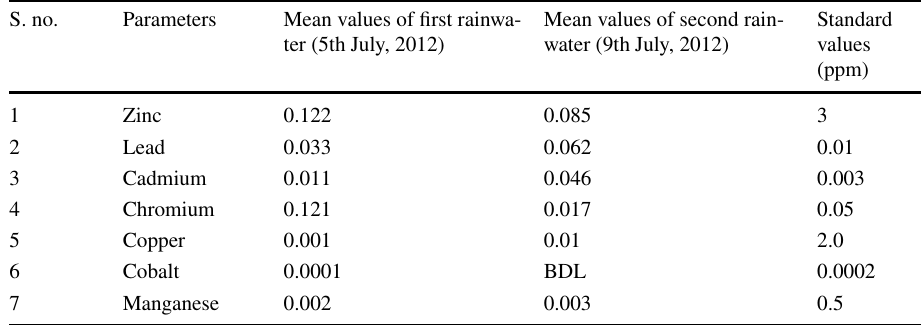
different heavy metals of rainwater samples collected from five zones of Lucknow city ( ppm parts per million or mg/l, BDL below detection